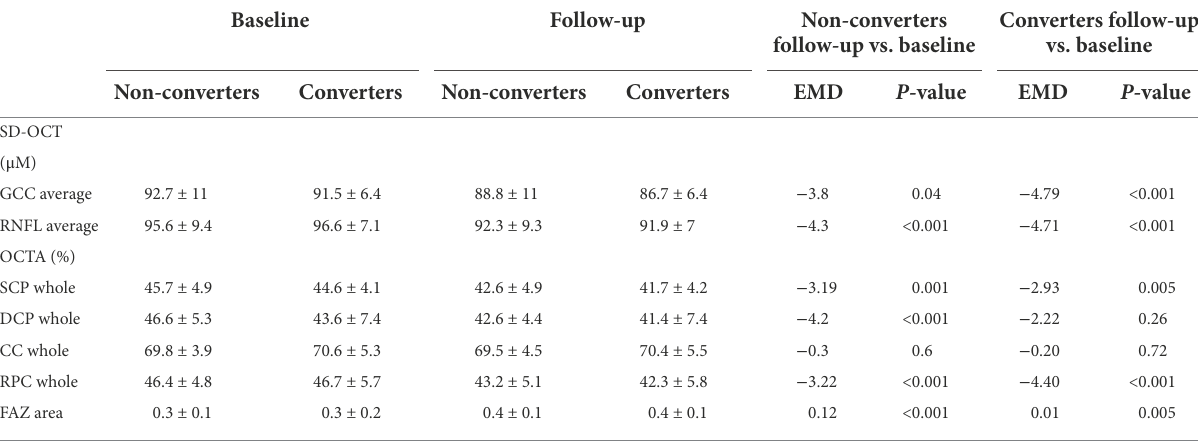
TABLE 3 Comparison in SD-OCT and OCTA parameters among non-converters vs. converters at baseline vs.